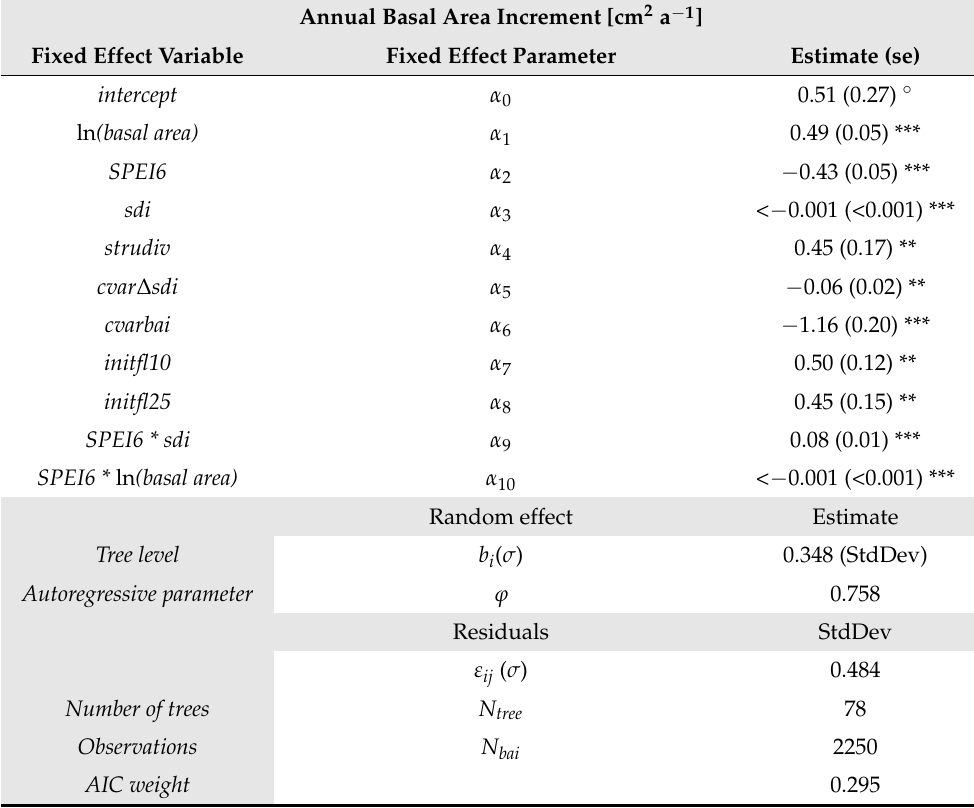
Table 2. Parameter estimates of the growth model for the period 1992–2020 (see Equation (5)): α are the regression coefficients of the fixed covariates; b represents the random intercept; ε is the error term; ϕ is the autoregressive parameter estimate accounting for temporal correlation. N tree describes the amount of examined trees and N bai the number of observations of the response variable. Significance levels: *** = 0.001, ** = 0.01, ◦ = 0.1.